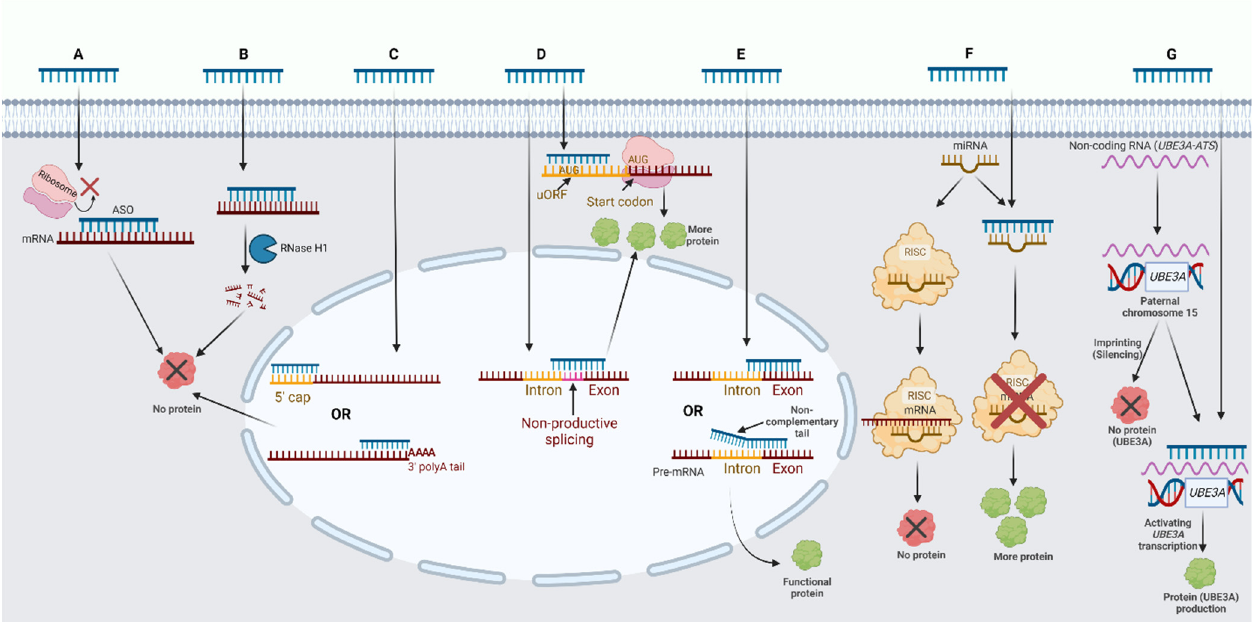
Figure 2. Antisense oligonucleotides (ASOs) can bind to mRNA and reduce the levels of toxic protein by ( A ) translational arrest due to the steric hindrance of ribosomal subunit binding, ( B ) inducing the RNase H1 endonuclease activity that cleaves RNA-DNA hybrids on mRNA, or ( C ) destabilizing pre-mRNA by inhibiting 5 ′ cap formation/modulating 3 ′ polyadenylation. ( D ) ASOs are able to increase gene expression by targeting upstream open reading frames within the 5 ′ untranslated region or nonproductive alternative splicing. ( E ) ASOs can modify mRNA splicing by targeting splicing enhancers/splicing silencers or inducing splicing enhancer by including a noncomplementary tail and alternate nonfunctional protein to improve function. ( F ) ASOs can target miRNAs and inhibit their RISC-dependent action to reduce protein translation. ( G ) Other noncoding RNAs can be the target of ASOs. ASOs targeting a noncoding transcript ( UBE3A-ATS ) were shown to activate paternal UBE3A gene expression in Angelman syndrome. “Schematic diagram created with premade icons and templates from biorender.com (accessed on 20 August